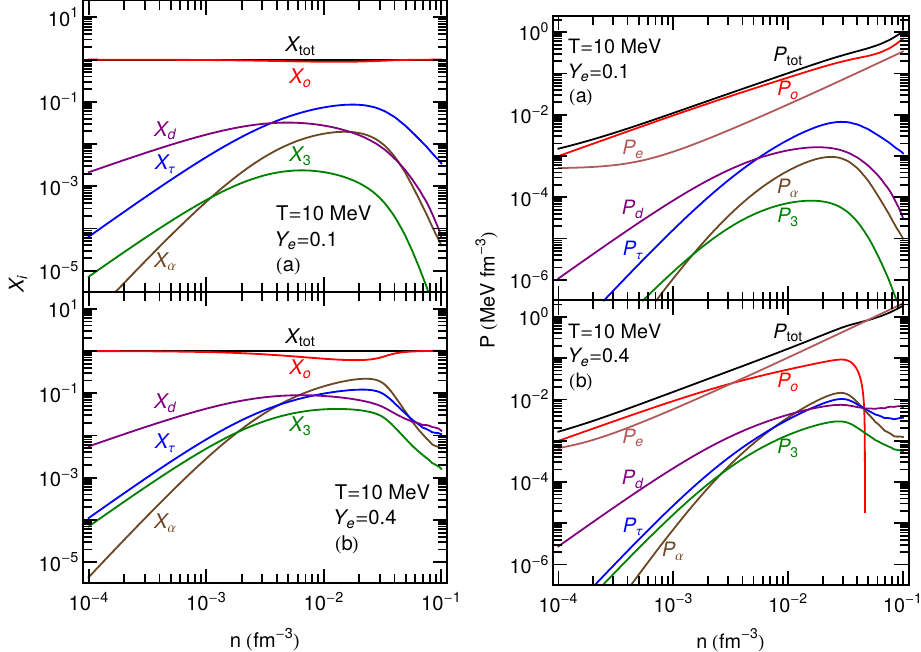
Figure 3. Mass fraction X i = A i n i / n ( left ) and pressure ( right ) as a function of baryon density for different electron fractions at T=10 MeV shown for the APR/EV approach. The subscripts d , τ , 3, α , e , and o correspond to contributions from deuterons, tritons, 3 He, alpha particles, electrons and outside nucleons (nucleons not bound in nuclei). The total mass fraction (=1) and total pressure are given by X tot and P tot ,